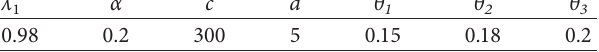
Table 4: Other parameters used in the equations. λ 1 α N ote. λ 1 is the freshness of agricultural products when it arrives at the supermarket, α is a sensitive factor of freshness to time, α > 0, c is the maximum market demand rate which is unaffected by the sales price and freshnessof products, d is the sensitivityfactor of demandrate tosales price, and θ 1 , θ 2 , and θ 3 represent the quantitative change coefficient of fresh agricultural products of farmers’ agricultural cooperative, distribution center, and supermarket,